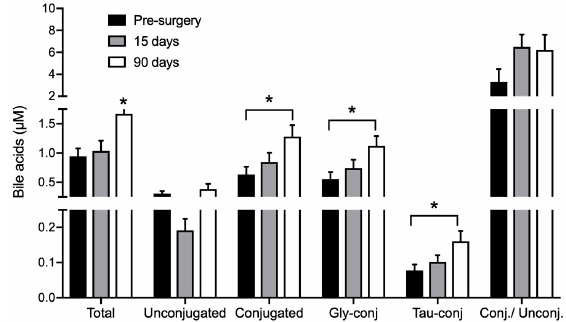
p < 0.05 compared to all groups, unless otherwise stated. Gly-conj: glycine-conjugated BA; Tau-conj: taurine-conjugated BA; Conj/Unconj: ratio between conjugated and unconjugated